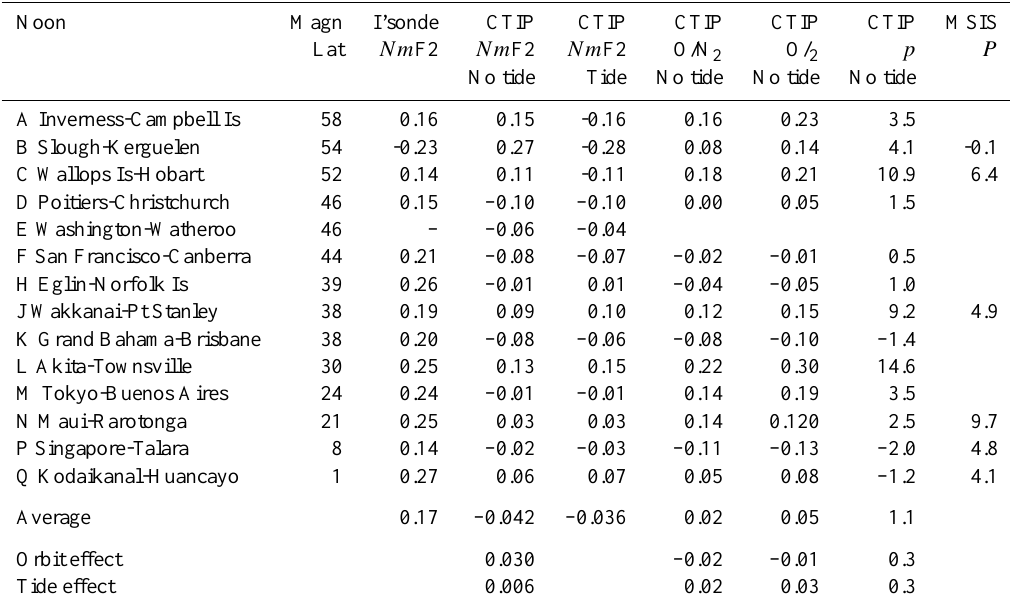
Table 5. Midnight annual asymmetry at pairs of stations for moderate solar activity ( F 10 . 7 ∼ 140). Ionosonde values are taken from Table 1 (and are averaged for the three pairs for which Table 1 values are at 100 and 180). CTIP values include varying Sun Earth distance. Neutral composition is computed at a fixed pressure- level. Orbit effect and tide effect as in Table 3. See text for further